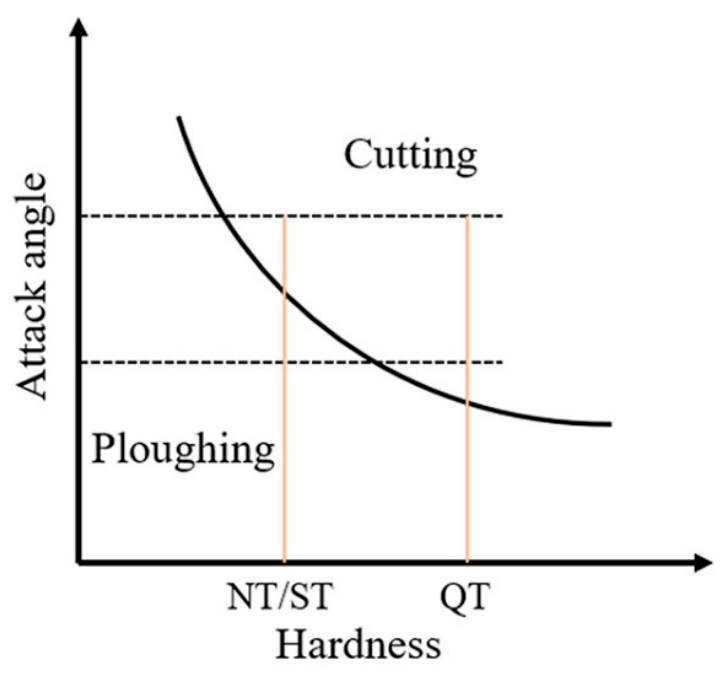
Figure 11. Schematic diagram of the transition of the abrasive wear mechanism.